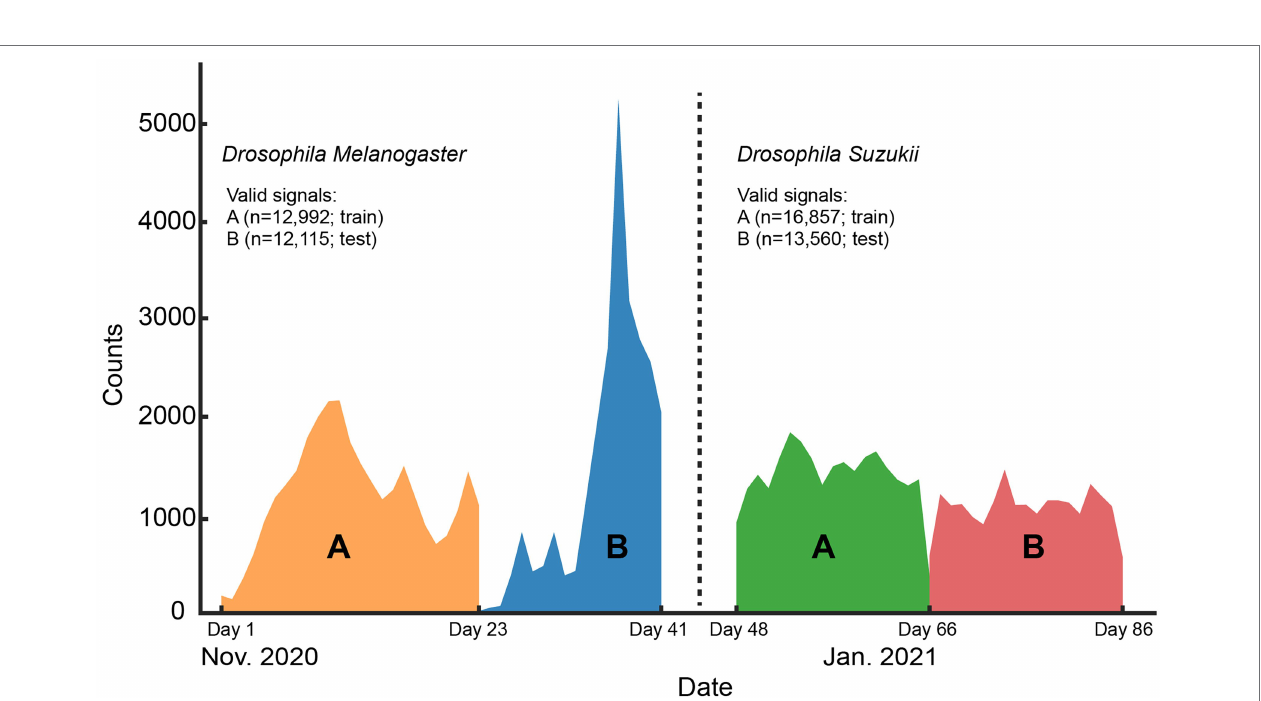
FIGURE 1 | Photograph of the laboratory setup with two insect cages and the wingbeat sensor. The wingbeat sensor consists of a sensing head, a data transfer cable and a microelectronic device with an SD card storage.